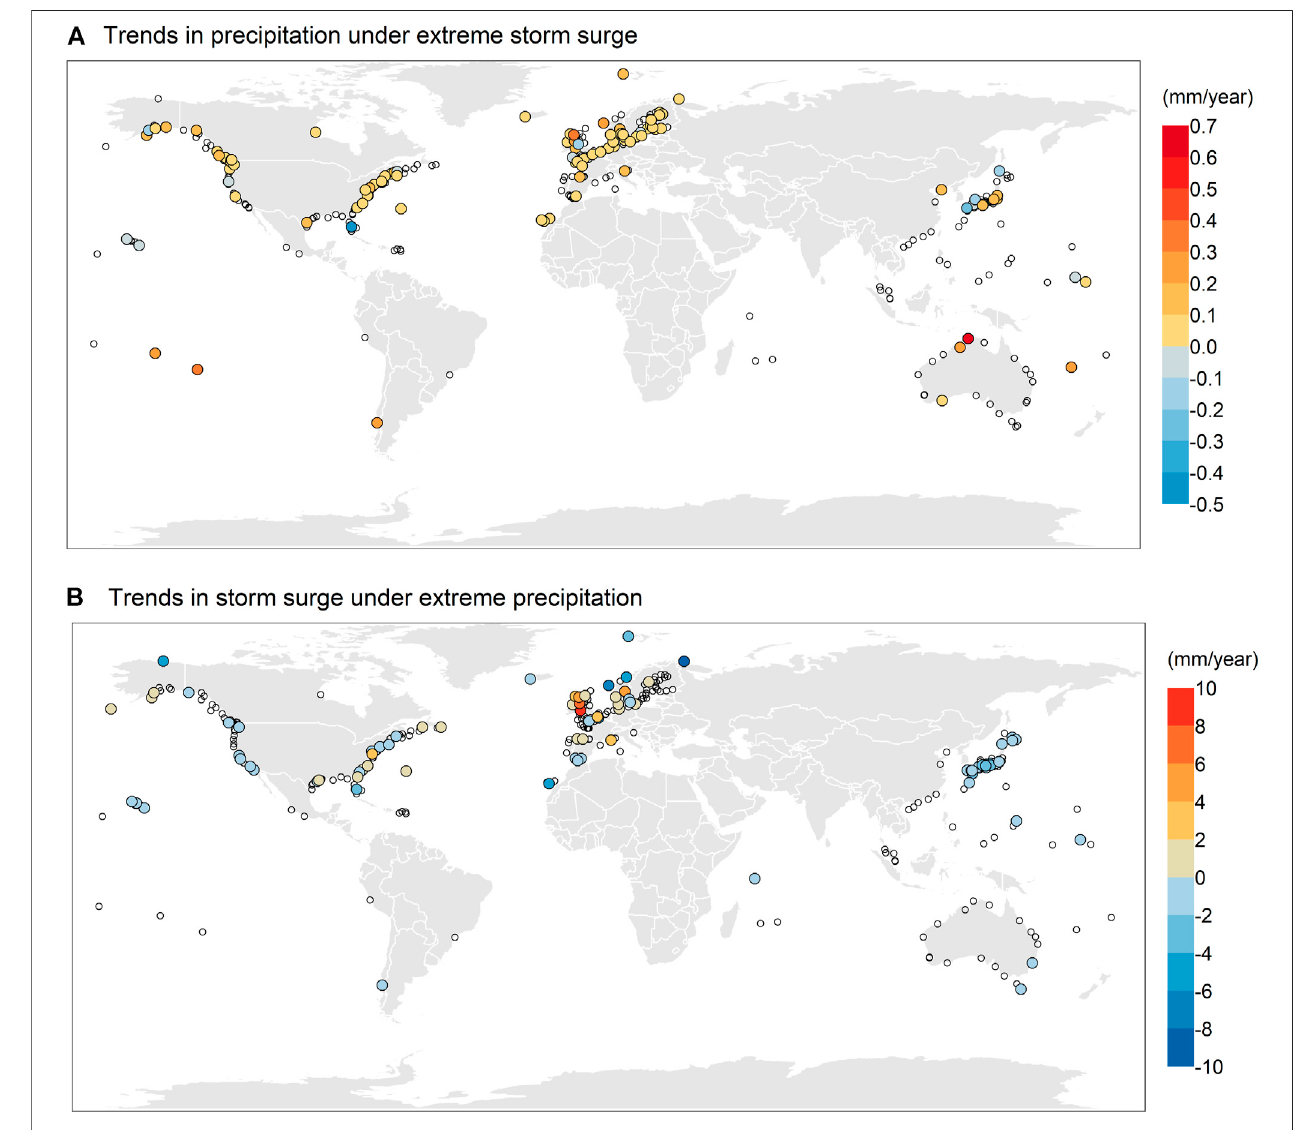
FIGURE 5 | Trends in (A) precipitation under extreme storm surge (i.e., > 90th percentile); and (B) storm surge under extreme precipitation (i.e., > 90th percentile). Open circles denote the insigni fi cant trends ( α (cid:1) 0.1).